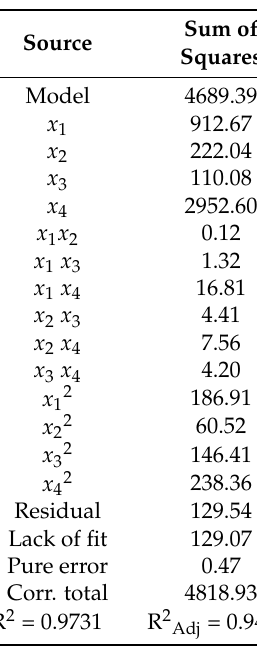
Table 3. ANOVA and fit statistic for the quadratic